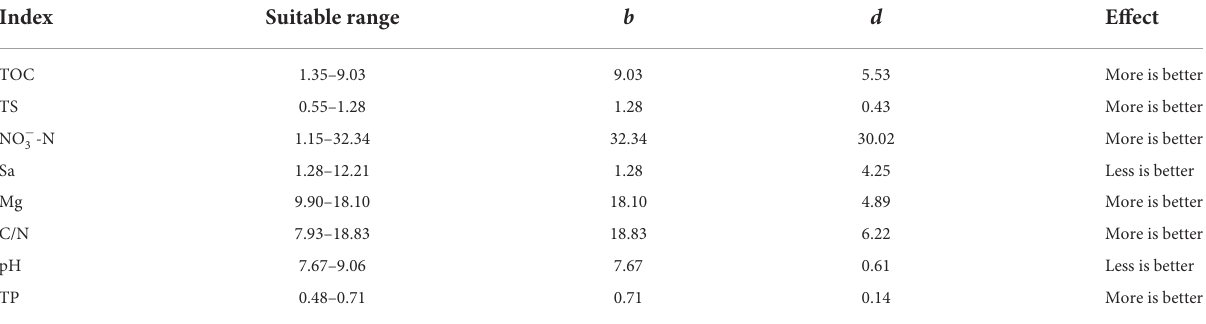
TABLE 3 The optimal ranges of MDS